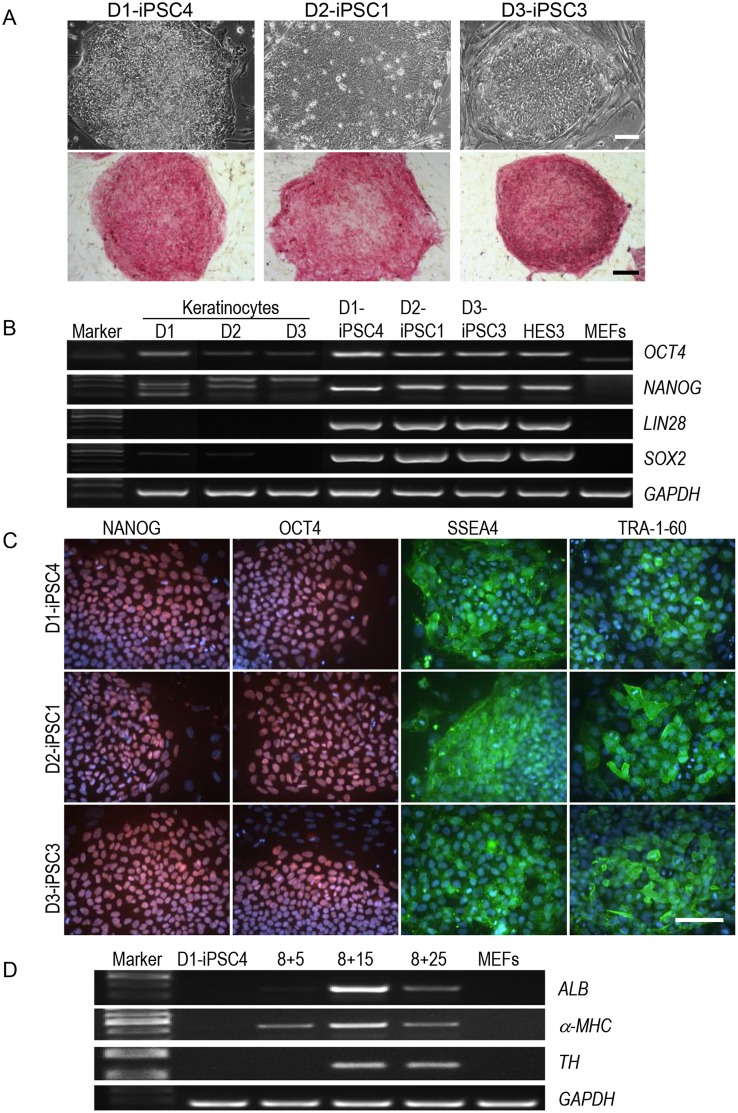
The hiPSC lines showed pluripotent characteristics.(A) The three hiPSC lines with typical morphology for human pluripotent stem cells expressed alkaline phosphatase. Scale bars: 100 μm. (B) The three hiPSC lines expressed endogenous pluripotency markers OCT4, NANOG, LIN28, and SOX2 at the mRNA level as shown by RT-PCR. GAPDH is included as loading control. HES3 cells and MEFs were included as positive and negative control, respectively. (C) Immunofluorescence staining of the hiPSC lines with Abs against pluripotency markers NANOG, OCT4, SSEA4, and TRA1-60. The cells were counterstained with DAPI (blue). Scale bar: 100 μm. (D) Germ layer-specific genes ALB, α-MHC, and TH were expressed in a developmentally controlled manner during EB differentiation. GAPDH is included as loading control. Analyses were performed at different stages (days 5, 15, or 25) during differentiation of EBs after plating at day 8 (d8). Marker, 100 bp DNA marker.